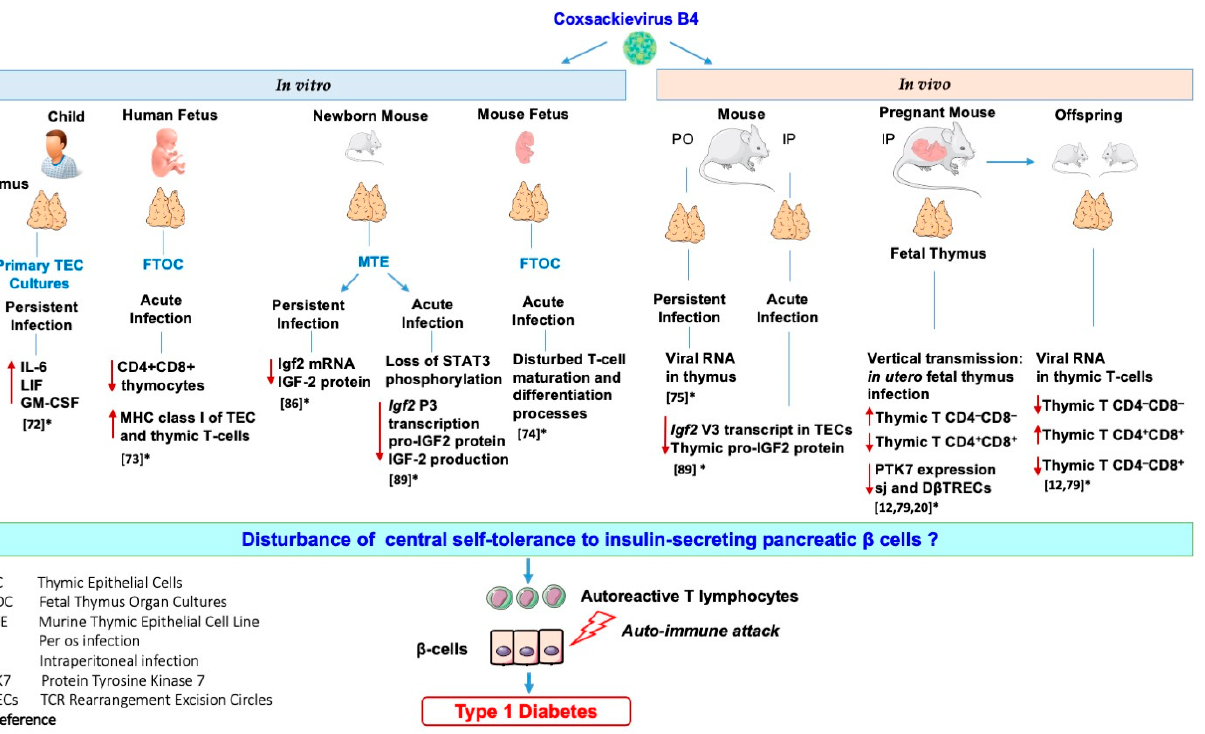
Figure 4. Effects of in vitro and in vivo Coxsackievirus B4 infection on the thymus and thymic cells: possible role in the disturbance of central tolerance to pancreatic β